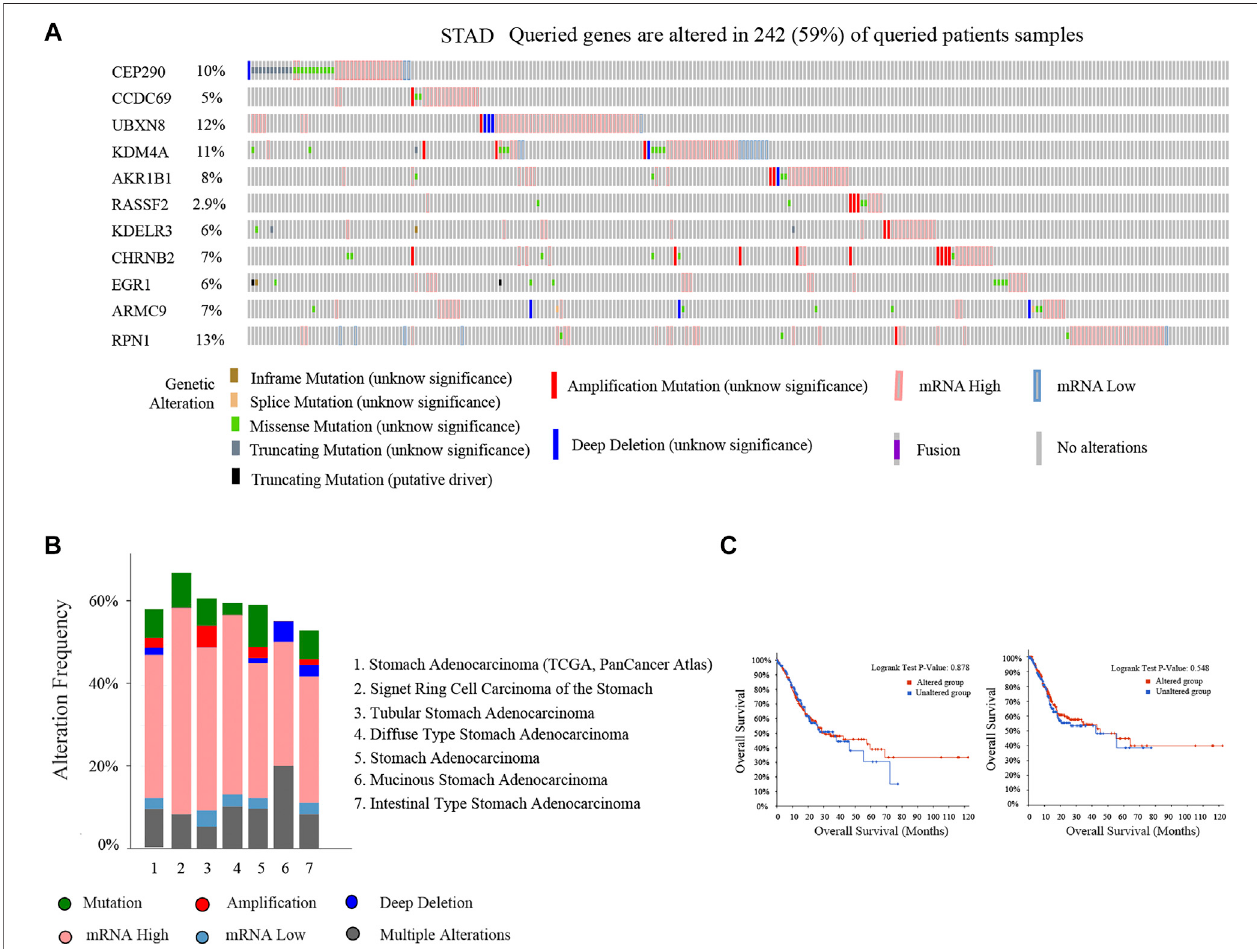
FIGURE 9 | Mutation of 11-DMG in gastric cancer (GC) patients (cBioportal). (A) A visual summary of 11-DMG mutation frequency. (B) Summary of mutation frequency of 11-DMG in gastric cancer patients. (C) Kaplan-Meier plotter was used to compare the relationship between gene mutation (red) and gene non-mutation (blue) of 11-DMG mutation with OS and PFS ( p < 0.05 statistical signi fi